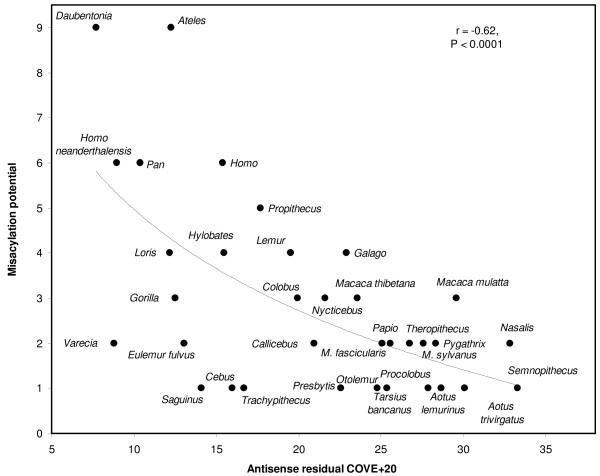
Misacylation potential as a function of antisense tRNA cloverleaf stability for the antisense of tRNA Tyr. The y axis is the number of amino acids with greater aminoacylation potential than serine, which is the predicted cognate for that antisense tRNA. The x axis is the residual of antisense COVE, from the linear regression between antisense COVE (dependent) with sense COVE (independent). Only taxa where sense-anticodon symmetry exists are considered, species are followed by NCBI accession numbers: Aotus lemurinus, FJ 85421; A. trivirgatus, AY 250707; Ateles belzebuth, FJ 785421; Callicebus donacophilus, FJ 785423; Cebus albifrons, NC 002763; Colobus guereza, NC 006901; Daubentonia madagascariensis, NC 010299; Eulemur fulvus, NC 012766; Eulemur mayottenis, NC 012769; Galago senegalensis, NC 012761; Gorilla gorilla, NC 001645; G. gorilla gorilla, NC 011120; Homo sapiens, NC 012920; Homo neanderthalensis, NC 011137; Hylobates lar, NC 002082; Lemur catta, NC 004025; Loris tardigradus, NC 012763; Macaca fascicularis, NC 012670; M. mulatta, NC 005943; M. sylvanus, NC 002764; M. thibetana, NC 011519; Nasalis larvatus, NC 008216; Nycticebus coucang, NC 002765; Otolemur crassicaudatus, NC 012762; Pan paniscus, NC 001644; P. troglodytes, NC 001643; Papio hamadryas, NC 001992; Pygathrix roxellana, NC 008218; Presbytis melalophos, NC 008217; Procolobus badius, NC 009219; Propithecus coquereli, NC 011053; Saguinus oedipus, FJ 785424; Semnopithecus entellus, NC 008215; Tarsius bancanus, NC 0021811; Theropithecus gelada, FJ 785426; Trachypithecus obscurus, NC 006900; Varecia varecia, NC 012773. Species explored but not included because of lack of anticodon symmetry in that specific tRNA are: Chlorocebus aethiops, NC 007009; C. pygerythrus, NC 009747; C. sabaeus, NC 008066; C. tantalus, NC 009748; Eulemur macaco, NC 012771; E. mongoz, NC 010300; Perodicticus potto, NC 012764; Pygathrix nemaeus, NC 008220; Pongo abelii, NC 002083; Pongo pygmaeus, NC 001646; Saimiri sciureus, NC 012775; Tarsius syrichta, NC 012774.